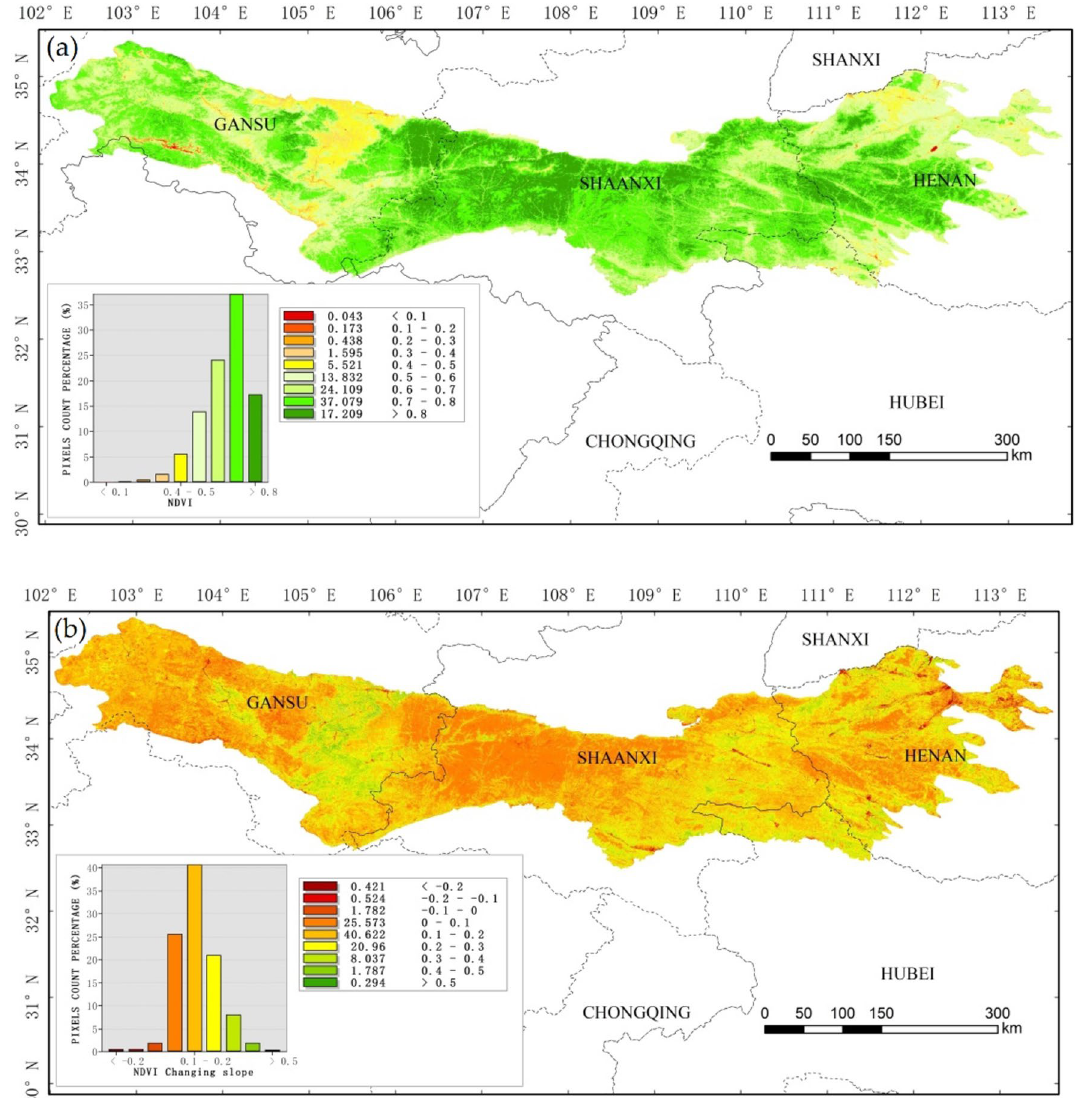
Figure 1. Spatial distribution ( a ) and changing trend ( b ) of NDVI in Qin Mountains during 1987–2018. The Landsat-derived NDVI here calculated from the Google Earth Engine (GEE) with high resolution and long time series. Theil–Sen Trend method that available in the GEE platform used to observe the changing trend of NDVI. The final map created in the ArcGIS